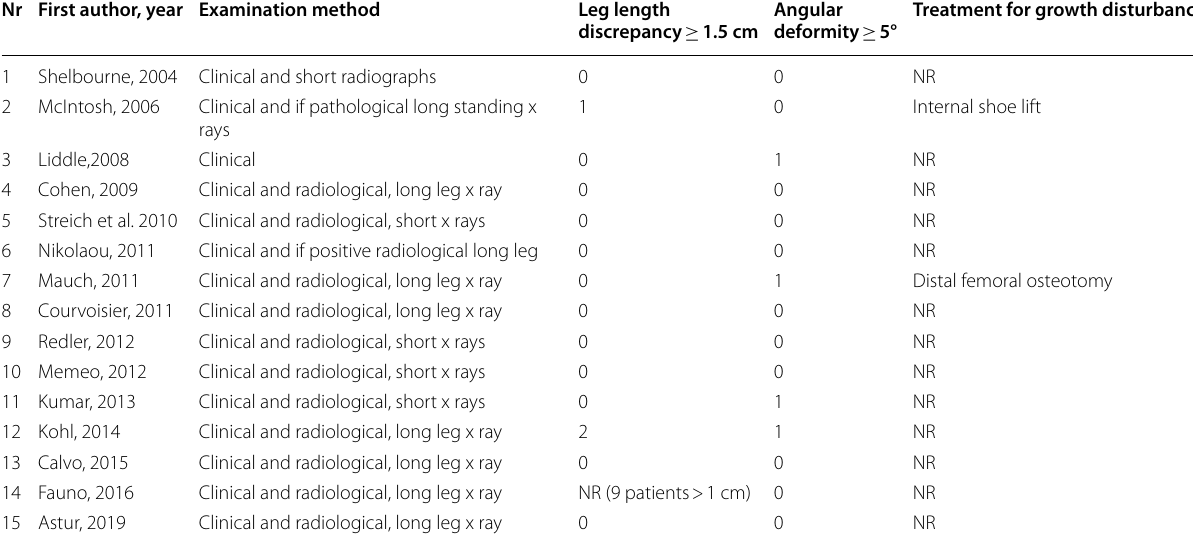
Table 4 Leg length discrepancies in studies using transtibial femoral drilling